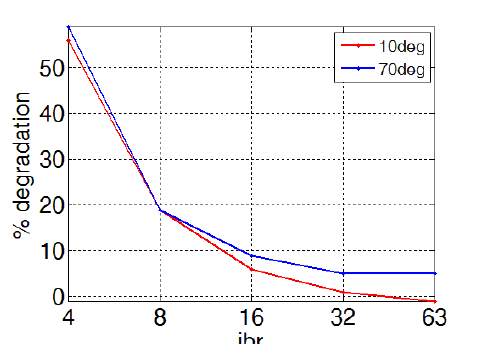
Figure 7: Degradation of the Concrete DTM at various ibr values, computed as percentage of the RMSE of the uncompressed original images (Table 1)